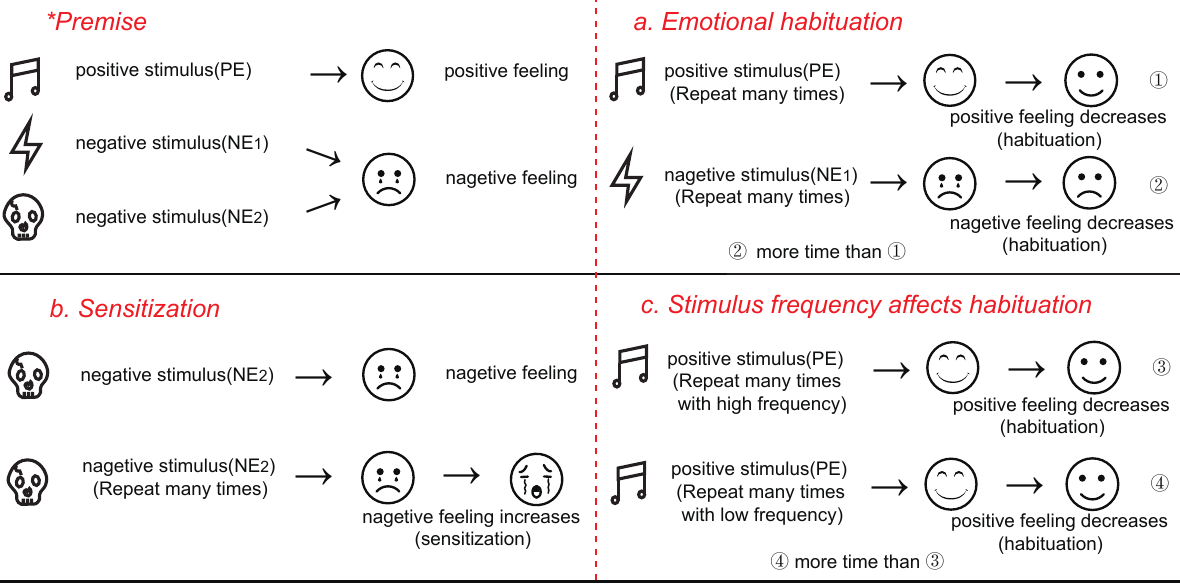
Figure 3. Illustration of nonassociative learning under different emotional stimuli. Emotional habituation is described in process a . When different emotional stimuli are applied, the brain will produce different feelings. When positive stimulus is applied at the beginning, strong positive feeling is generated. The degree of the positive feeling will slowly decline with positive stimulus repetition, which indicates that emotional habituation occurs. A similar phenomenon occurs with negative stimulus repetition. The difference is that it takes longer to form habituation under a negative stimulus than under a positive stimulus. The phenomenon shows that emotional habituation shows a negative bias, which maintains a high degree of arousal of negative emotional stimulus and avoids the harm caused by the negative